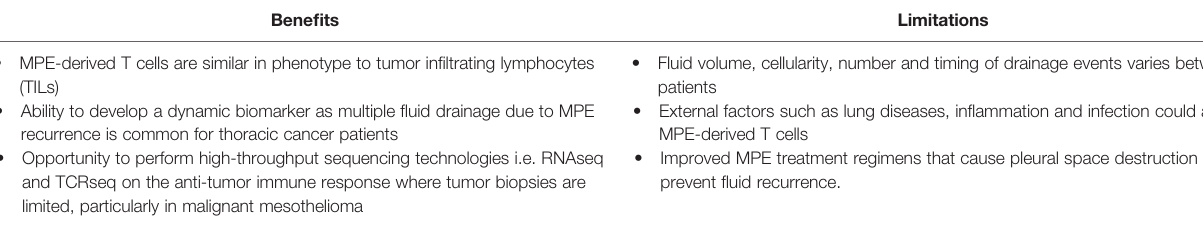
TABLE 2 | Bene fi ts and limitations for using the MPE to develop T cell biomarkers for ICB therapy response. Bene fi